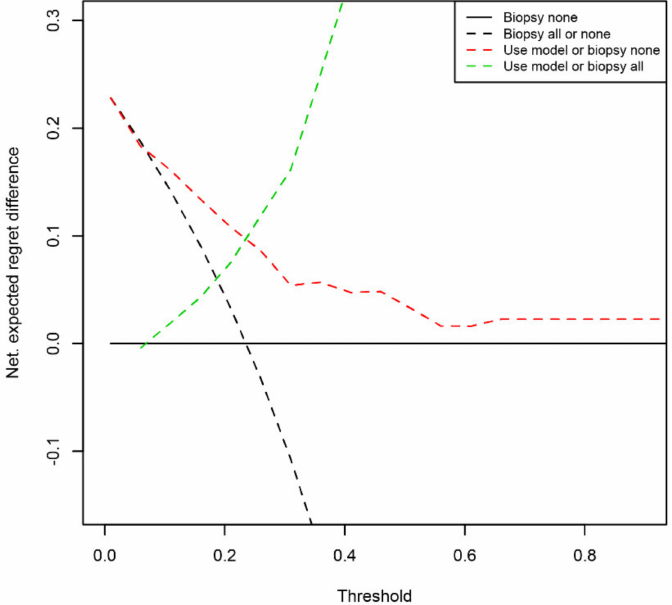
Figure 2. Expected Regret Difference. The net Expected Regret Difference of using the model3.2 for biopsy indication in pair-wise comparison. Within a threshold range of 7% and 97%, our model provided a benefit over both extreme